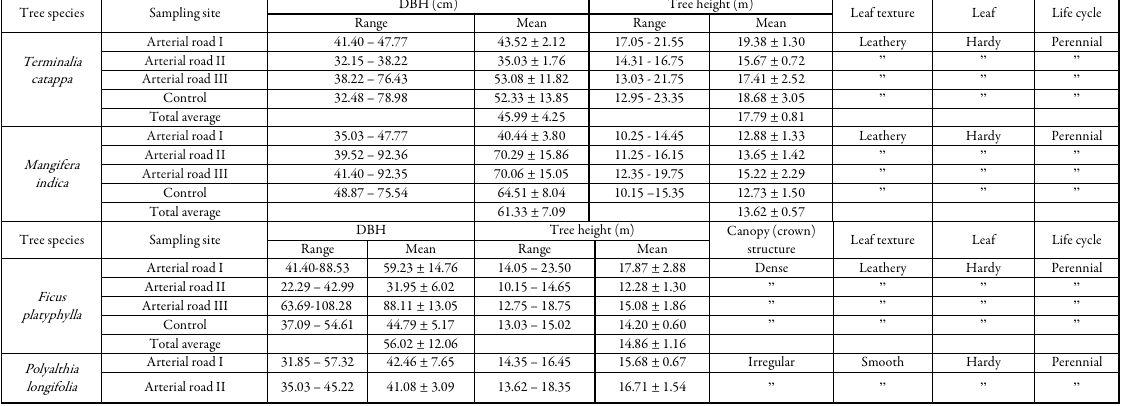
Table 3. Morphology of the selected roadside trees at study sites in the Kumasi Metropolis Tree species Sampling site